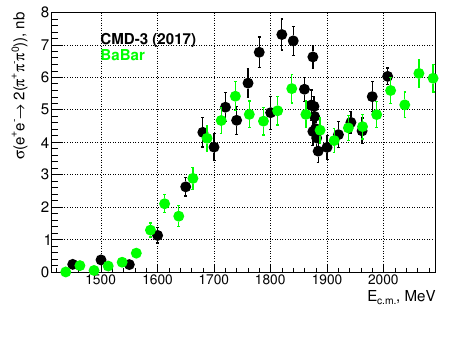
Figure 6. The e + e − → 2( π + π − ) cross section measured with CMD-3 (dots) and BaBar [31] (open circles). The vertical lines show the p ¯ p and n ¯ n thresholds.